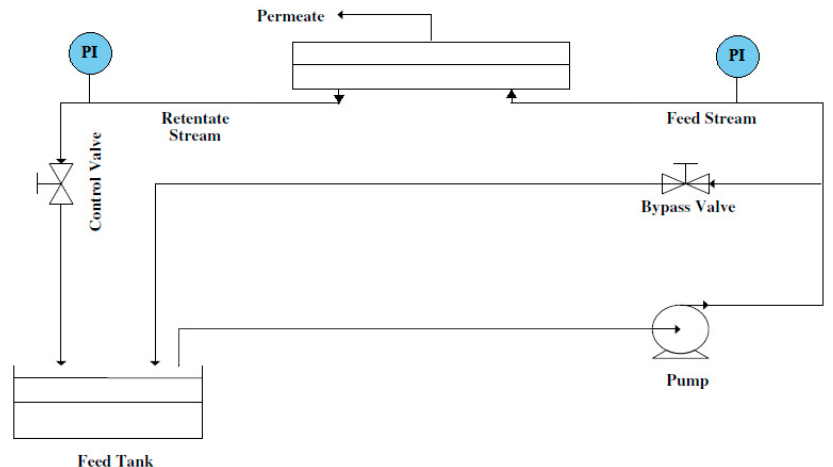
Figure 1. Schematic sketch of the lab-scale experimental setup used for the membrane filtration studies.